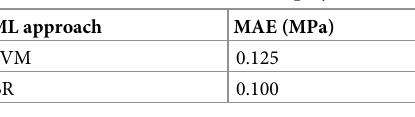
Table 2. Statistical checks for the employed ML